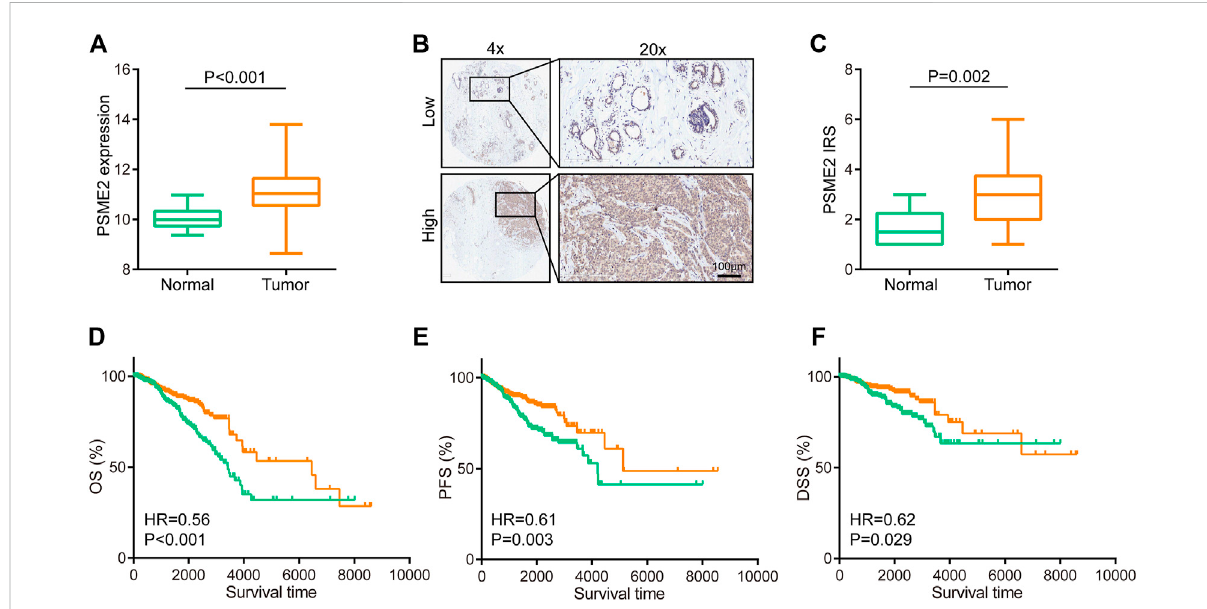
FIGURE 1 Expression and prognostic value of PSME2 in BrCa (A) Expression level of PSME2 in tumor and para-tumor tissues. Compared with para-tumor tissues, PSME2 was highly expressed in tumor tissues. Data was obtained from the TCGA dataset (B) Representative images revealing PSME2expressionintumorandpara-tumortissuesusinganti-PSME2staining (C) ExpressionlevelofPSME2proteinintumorandpara-tumortissues. Compared with para-tumor tissues, PSME2 was highly expressedin tumor tissues (D – F) Prognostic valueof PSEM2 in BrCa in terms ofOS, PFS, and DFS. High expression of PSEM2 was associated with well prognosis in BrCa. Data was obtained from the TCGA